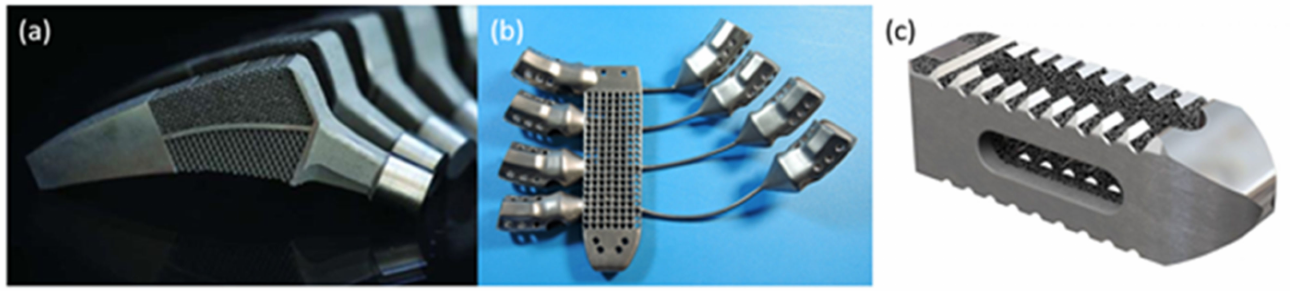
Figure 7. Examples of metallic AM implants using EBM and SLM processes, specifically ( a ) titanium alloy femoral stem implant with complex lattice structures for improved Osseo integration by TU Delft using SLM, ( b ) patient-specific titanium sternum and ribs using EBM by Anatomics, ( c ) serial produced titanium posterior lumbar cage with porous structures using SLM by Stryker